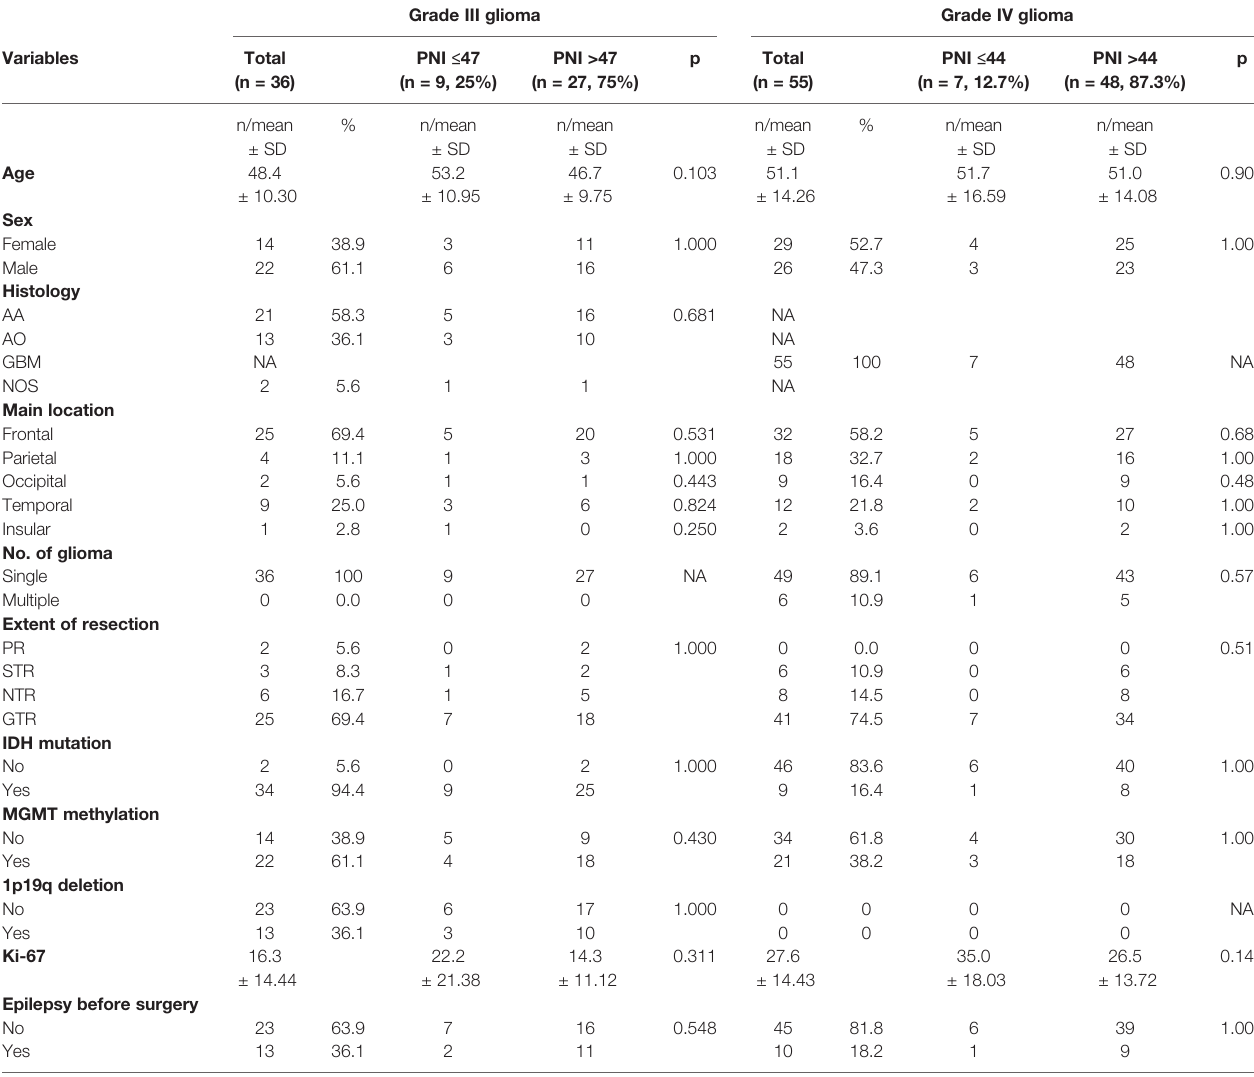
TABLE 1 | Baseline patient characteristics strati fi ed by preoperative PNI in grade III glioma and grade IV